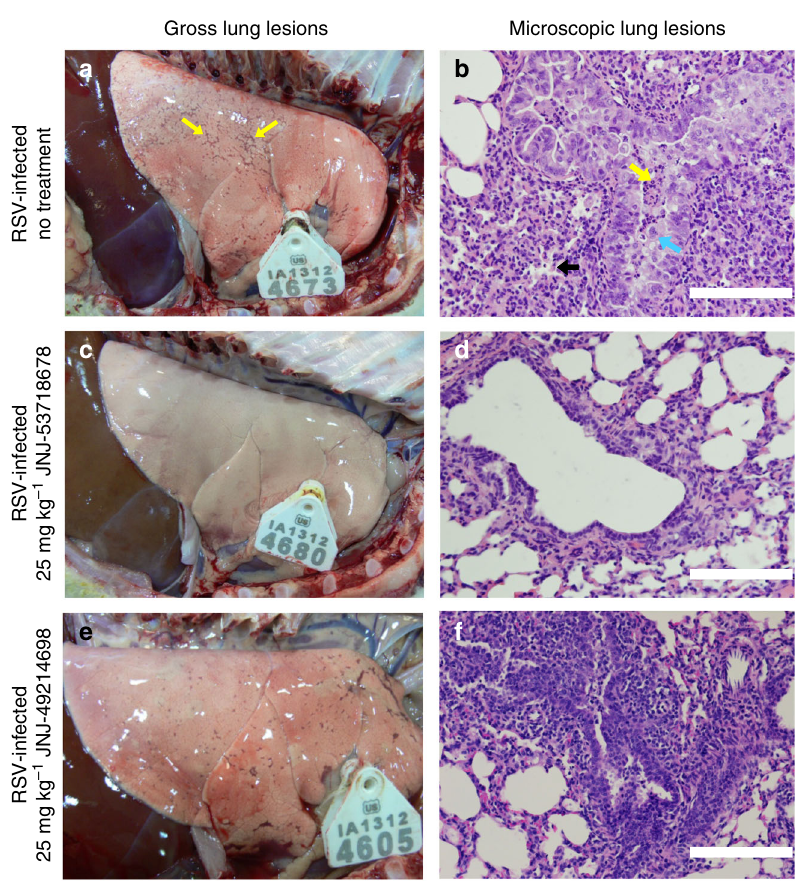
Fig. 5 Effect of RSV fusion inhibitors on RSV-induced lung pathology in neonatal lambs. a – f Gross a , c , e and microscopic b , d , f lung lesions on Day 6 post infection with RSV in vehicle-only-treated 1 – 3-day-old lambs of both sexes a , b in lambs that received once-daily dose of 25 mg kg − 1 JNJ-53718678 c , d starting 24 h after infection, or in animals that received once-daily dose of 25 mg kg − 1 JNJ-49214698 e , f starting 72 h after infection. Yellow arrows indicate RSV-induced gross lesions a . Blue arrow indicates the formation of a syncytium within bronchiolar epithelium that is somewhat thickened by hyperplasia b . Black arrow indicates a collapsed alveolus b . Yellow arrow indicates intraluminal neutrophils b . Black bars = 100 µ m b , d ,